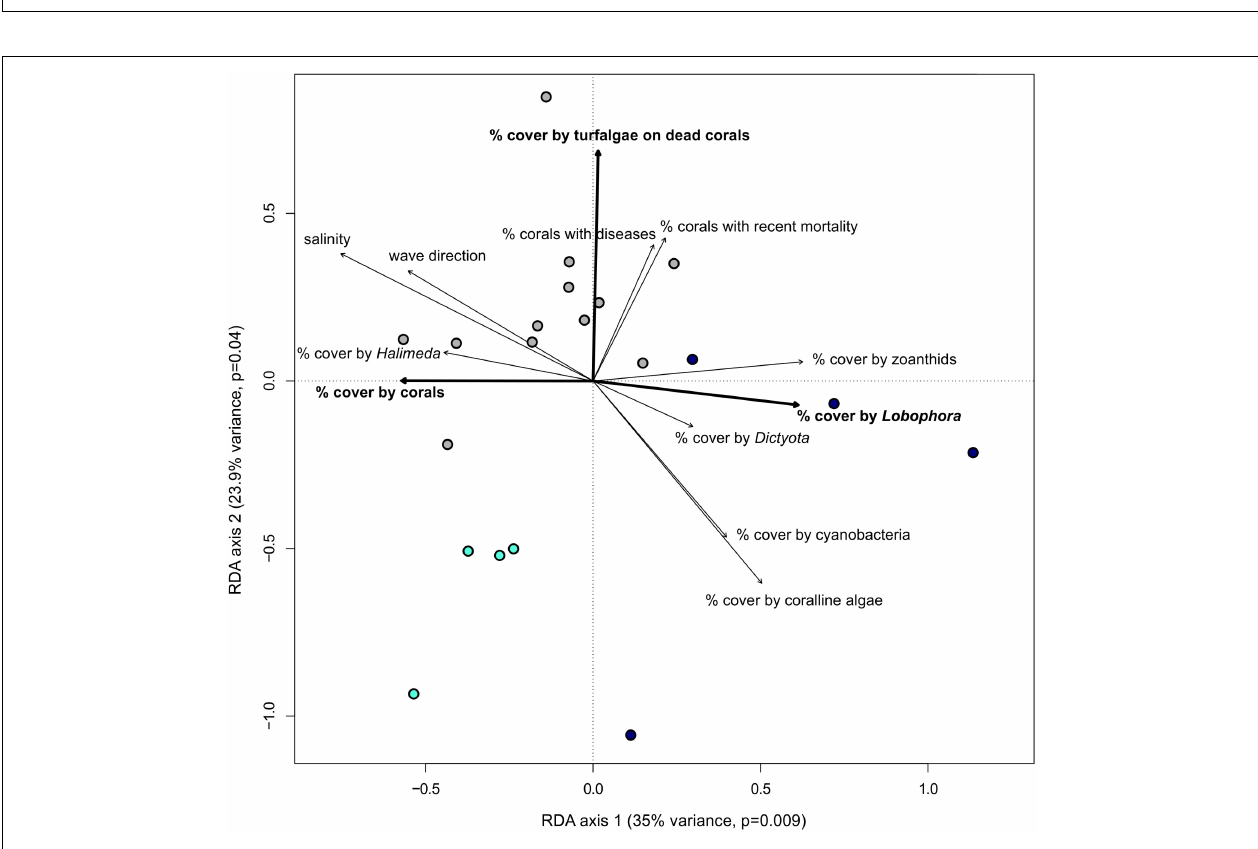
FIGURE 5 | Bold environmental variables have a significant impact ( p < 0.05) on the population structure of Gambierdiscus caribaeus based on the RDA analysis. The other environmental variables distinguish genetic clusters from each other based on one-way ANOVA. Circles represent approximate monthly algal groups from high-resolution sampling period at USVI: dark blue circles = USVI_1308-1403, gray circles = USVI_1404-1510, turqouise circles = USVI_1511-1604.